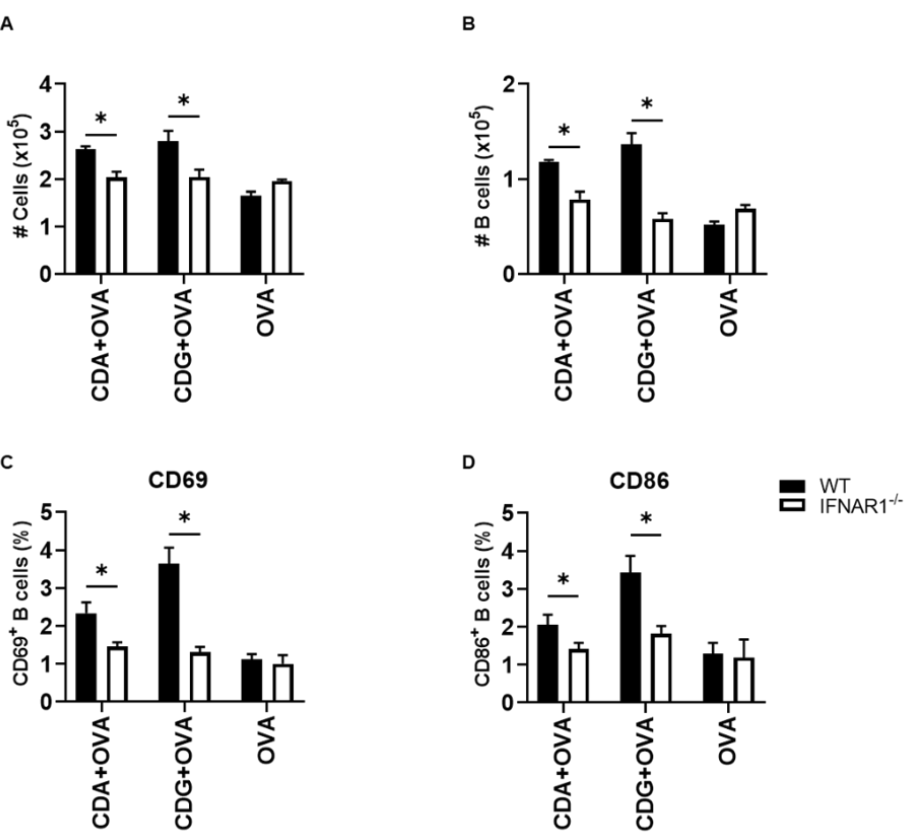
Figure 3. CDG-mediated expansion and activation of B cells are type I IFN dependent. B cell expansion and activation were assessed in vaccinated WT and IFNAR1 −/− mice following rechallenge with OVA-pulsed target cells. The bar graphs show the absolute count of ( A ) total cells and ( B ) B cells and the frequency of activated ( C ) CD69 + and ( D ) CD86 + B cells in the inguinal lymph node of vaccinated mice. Error bars indicate SEM. Statistical significance was calculated using one-tailed Student’s t -test. * indicates p < 0.05. The results are representative of two independent experiments (WT, n = 4; IFNAR1 −/− , n = 3–4).